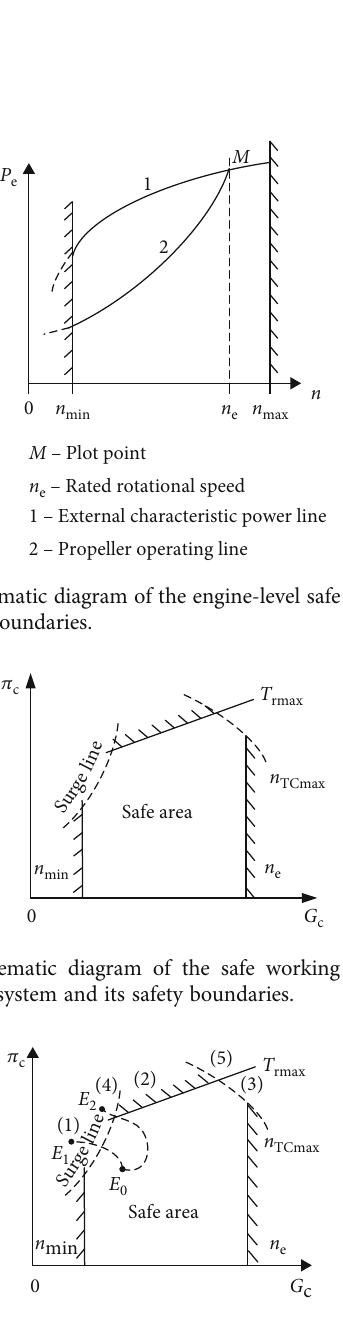
Figure 7: Schematic diagram of the safe working area and failure modes for the turbocharging